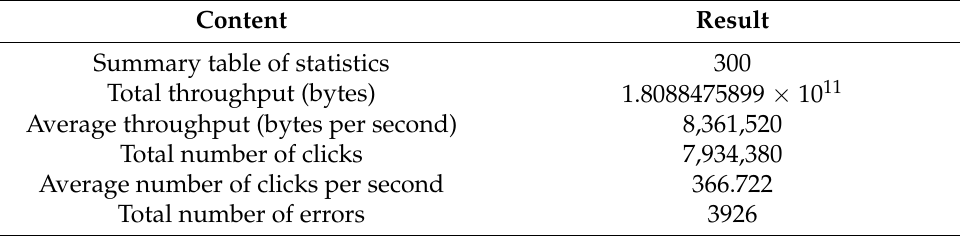
Table 4. Summary table of statistics.